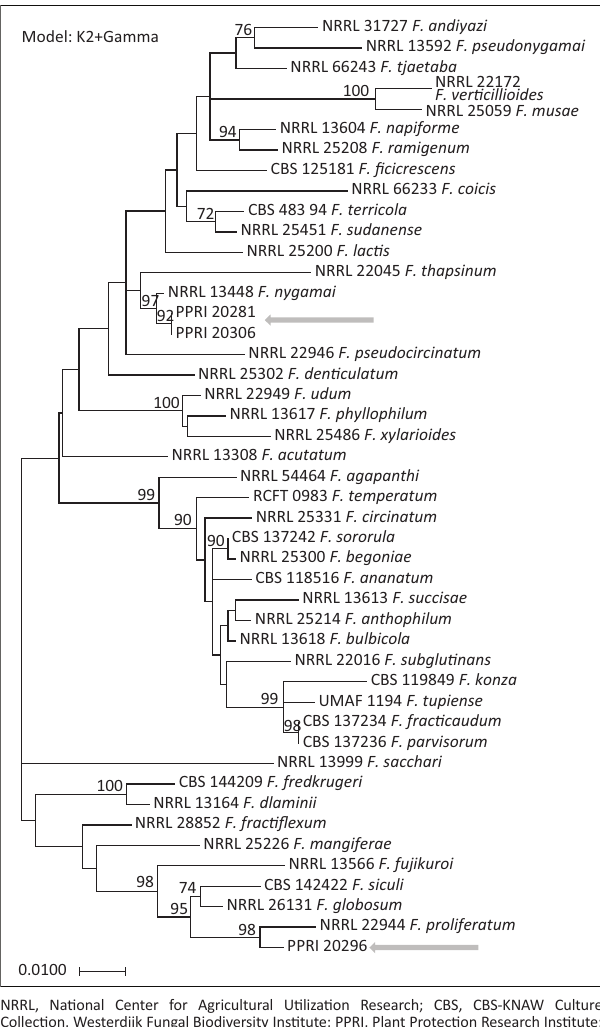
FIGURE 1: Unrooted maximum likelihood phylogram of all currently sequenced Fusarium species in the Fusarium fujikuroi species complex based on translation elongation factor 1-a gene sequences. Bootstrap support values higher than 80 % are shown on the branches. The evolutionary model applied to the analysis is indicated on the figure. Isolates from this study are indicated with PPRI